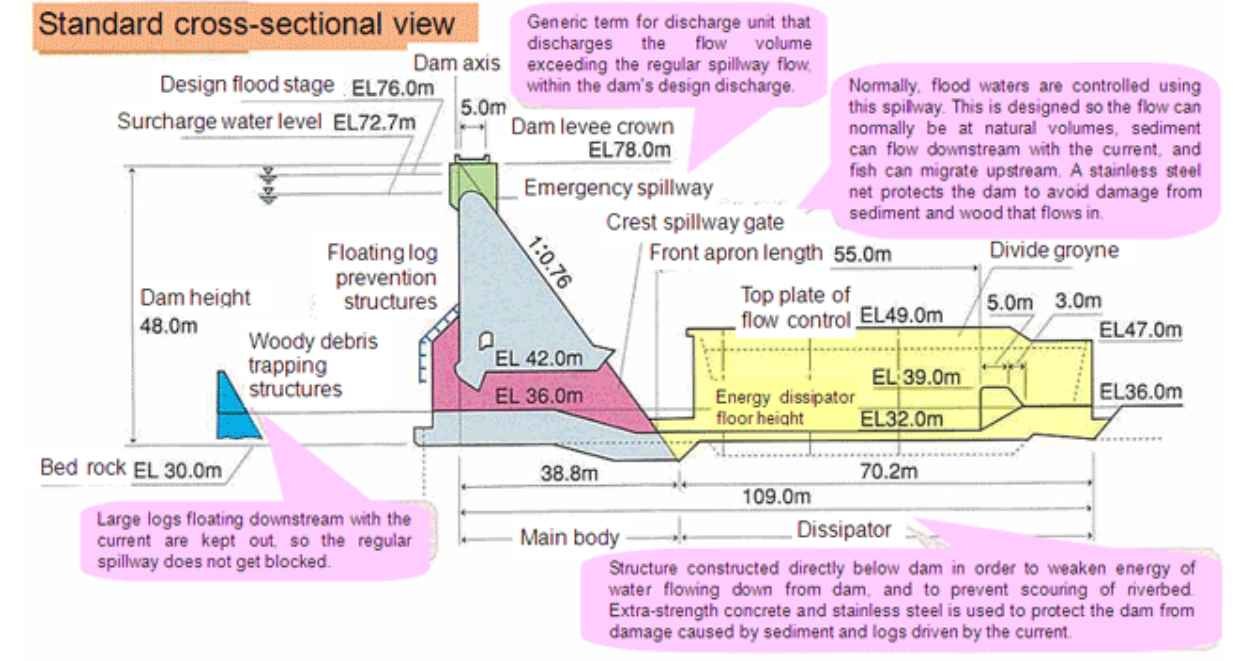
Figure 16. Diagram of a flow-through dam for flood control purposes (United Nations).